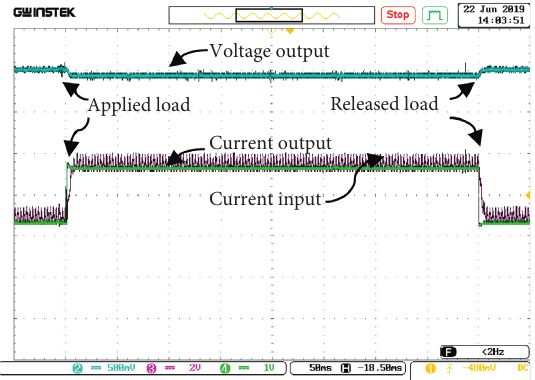
Figure 19: Result of voltage response and current using a PI controller with GA search.